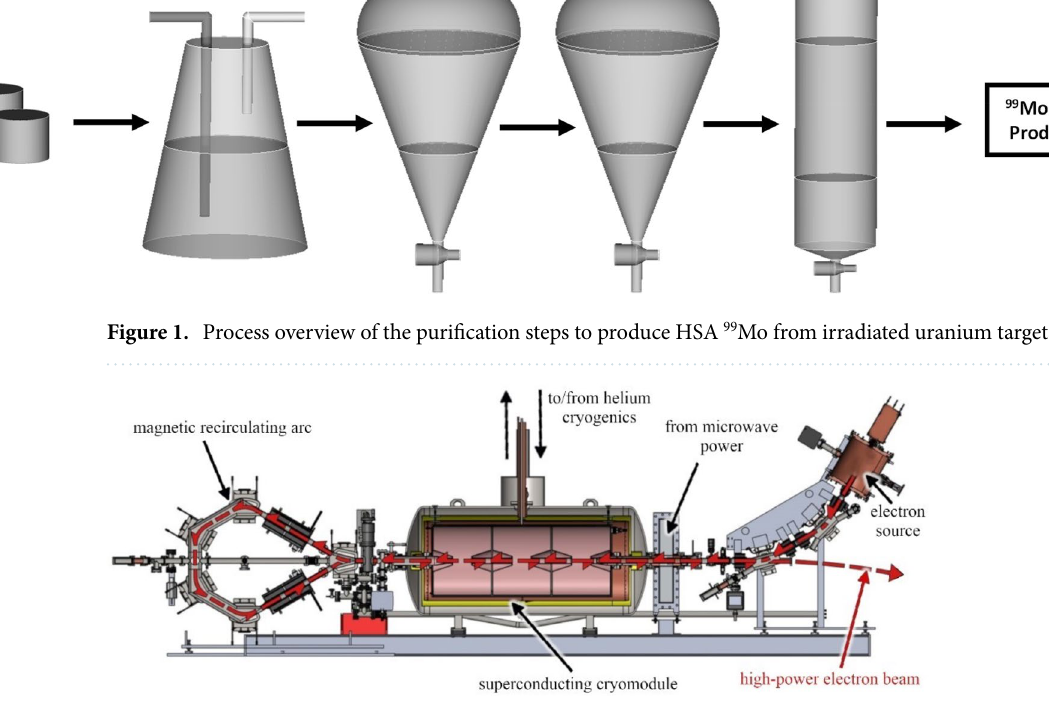
Figure 2. Niowave superconducting electron accelerator, which uses a magnetic recirculation arc to accelerate the electron beam twice in a single superconducting RF